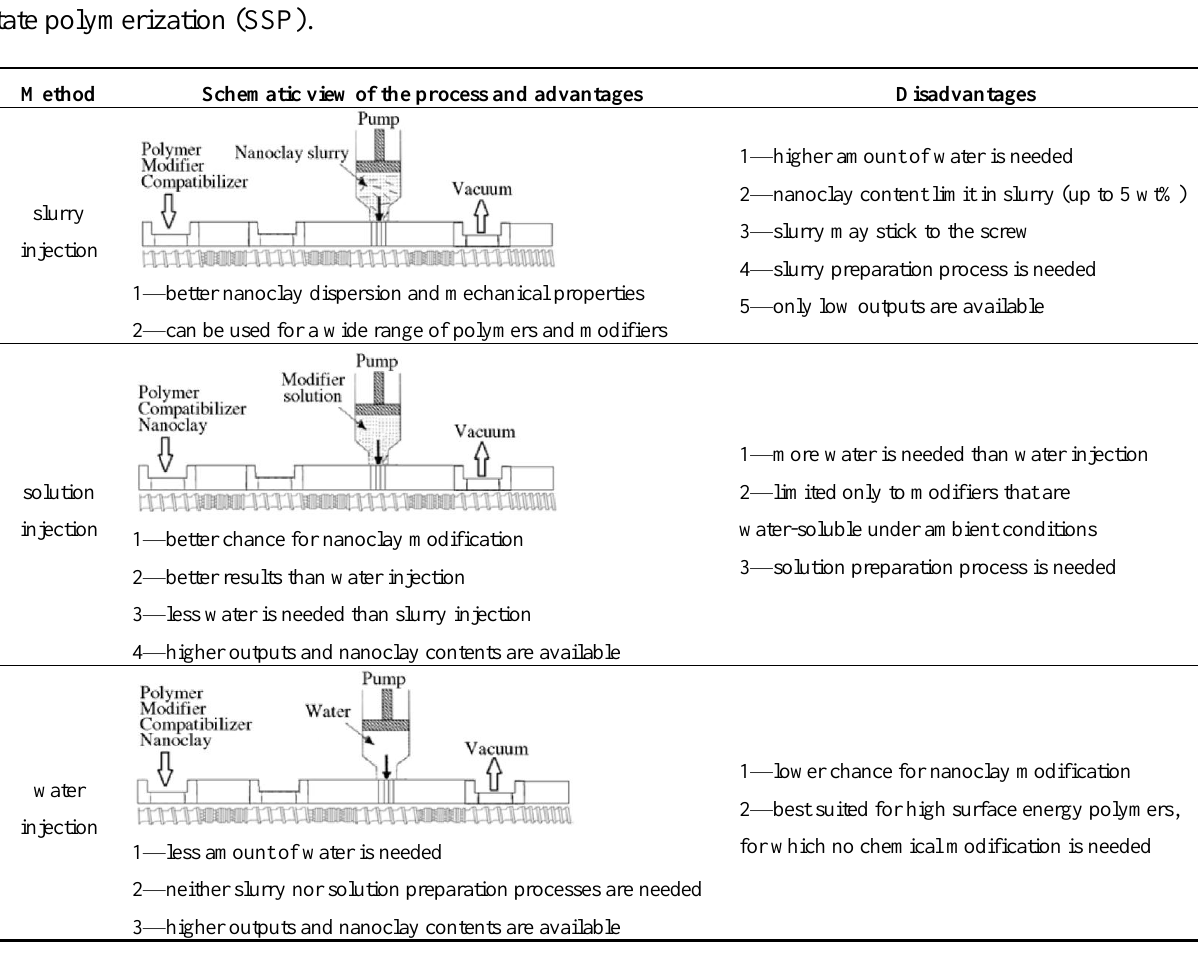
Figure 3. Advantages and disadvantages of various water-assisted (WA) melt compounding techniques introducing aqueous dispersion of the clay (“nanoclay”), aqueous solution of the modifier, or only water into the high pressure zone of an extruder (with permission of BME-PT) [30]. The “modifier” is a cationic surfactant which can replace the initial Na + ions in between the clay